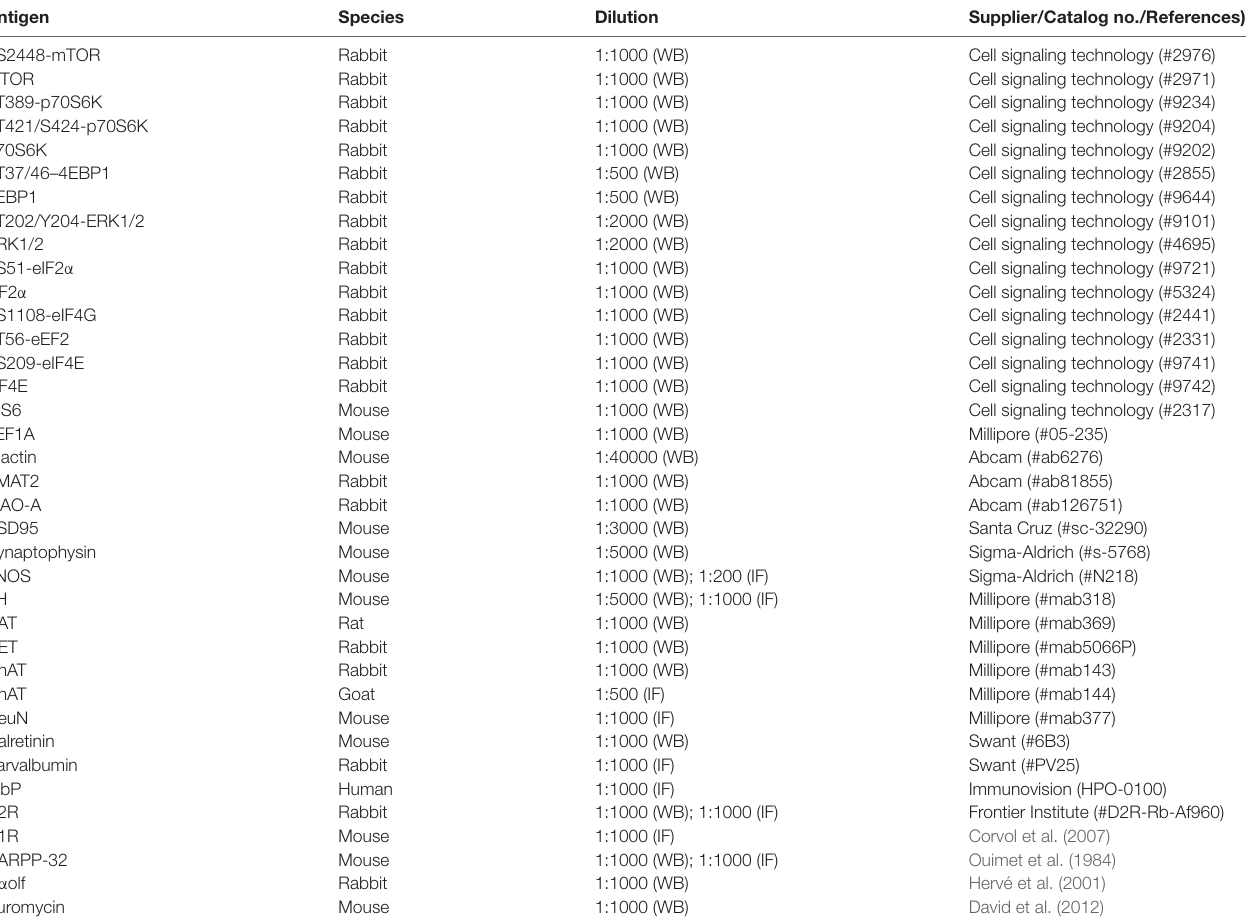
TABLE 1 | List of primary antibodies. Antigen Species Dilution Supplier/Catalog no./References) pS2448-mTOR